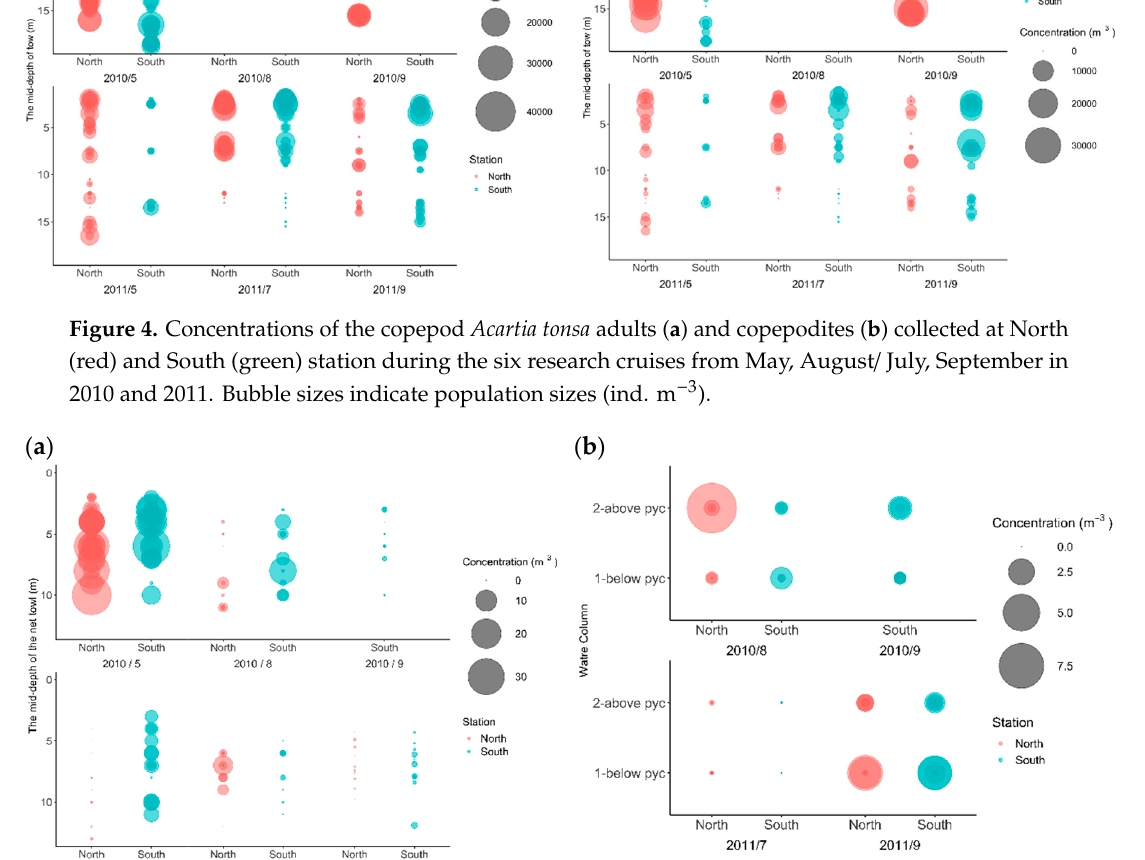
Figure 6. Concentrations of gelatinous zooplankton; comb jelly ( Mnemiopsis leidyi , ( a ) and bay nettle ( Chrysaora chesapeakei , ( b ) collected at North (red) and South (green) station during the six research cruises from May, August/July, September in 2010 and 2011. Bubble sizes indicate population sizes (ind. m − 3 ). 3.3. Grouping with PCA Results Among the nine principal components in our analysis, PC1 explained 56% of the variance, and PC2 explained 26% of the variance; together, these two principal components explained 82% of the variability in environmental conditions (Table 1). Because only PC1 and PC2 had eigenvalues larger than 1, and the cumulative sum increased slowly after PC2, only PC1 and PC2 were retained for further analysis (Table 1). The top three loadings of PC1 were water temperatures in the bottom layer, pycnocline, surface layer, indicating water temperature was the major driving factor of PC1 (Table 2). The top three loadings of PC2 included dissolved oxygen of the bottom layer as well as the salinity of the bottom and surface (Table 2), indicating that bottom dissolved oxygen and salinity in both the bottom and surface layers were the major drivers of PC2 (Table 2). The scatter plot of PC1 and PC2 scores for 335 CTD casts is provided (Figure 7). Because the major loading in PC1 was water temperature, which was negatively related to PC1 (Table 2). All data were grouped into three temperature categories approximately corresponding to PC1 scores − 4 to − 2, − 2 to 0, and 0 to 2, named “Warm (W)”, “Temperate (T)”, and “Cool (C)”, respectively. Because bottom dissolved oxygen was